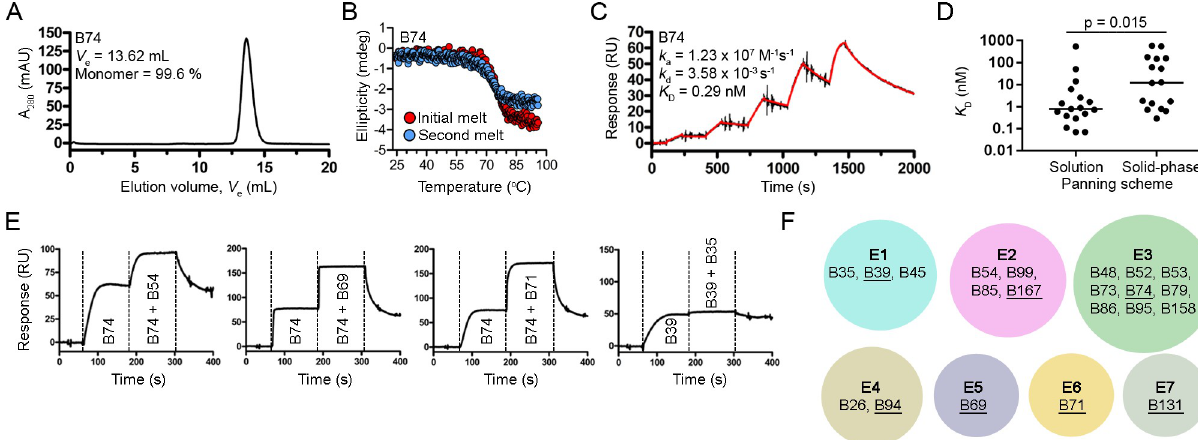
Fig 2. Biophysical characterization of V H Hs. Representative SEC profile (A) and thermal unfolding curve from initial and refolded thermal melts (B). (C) Representative SPR single-cycle kinetics sensorgram showed high-affinity binding of V H Hs to biotinylated TcdB 1751-2366 immobilized on a CAP sensor chip. (D) Plot comparing K D s of V H Hs isolated from solution and solid-phase panning schemes. The four V H Hs isolated from both panning schemes were included in the analyses. Bars represent the median K D and a P -value < 0.05 was considered significant (Mann Whitney two-tailed unpaired t -test). (E) Representative sensorgrams demonstrating SPR-based epitope binning. All V H Hs were injected at 10x K D concentrations. (F) Summary of the TcdB 1751-2366 epitope bins identified in this study by the pool of V H Hs tested. The V H Hs in each epitope (E) bin are noted and the underlined V H Hs represent the highest affinity and/or slowest dissociating antibodies in each bin.